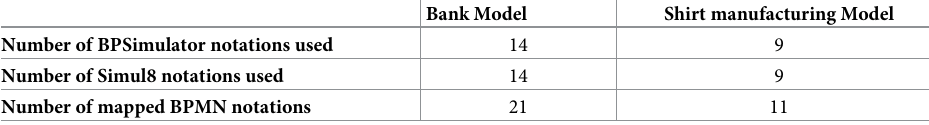
Table 6. Number of notations used to build both models and generated BPMN model.